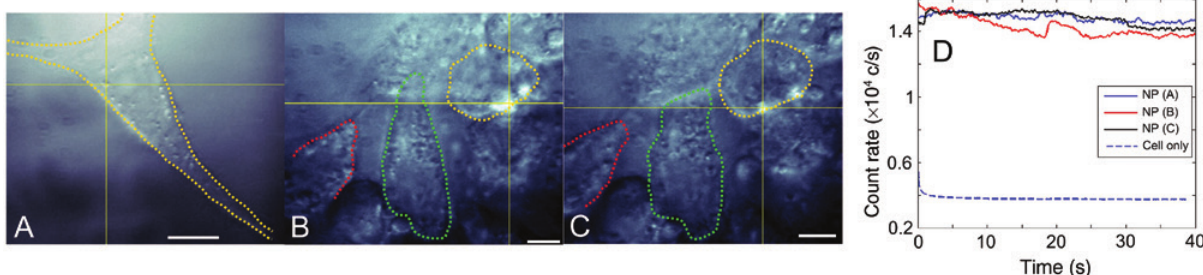
Figure 6: Wide-field confocal fluorescence images of the (A) filtered and (B and C) unfiltered ZnO NP solution in PBS in vitro . The contours of some cells have been highlighted with dashed lines as a reference. The scale bars are 10 μ m in length. (D) Count traces were obtained at the centre of the cross hairs with 4 × 4 pixel area binning of the intensity, where the blue, red, and black lines represent the count traces from A to C. The blue dashed line is also shown as a comparison to emphasise the photobleaching behaviour of the HaCaT cell only from Figure 5C. The count traces were obtained within the wide-field confocal